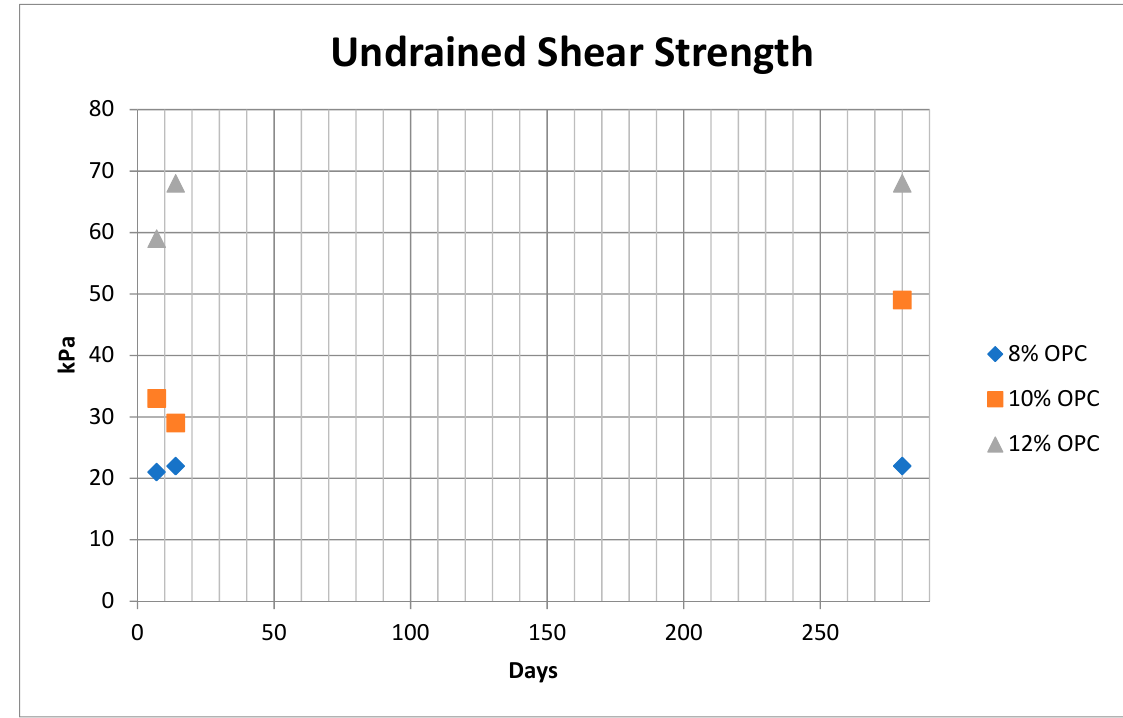
Figure 8. Undrained shear strength of OPC mixes.